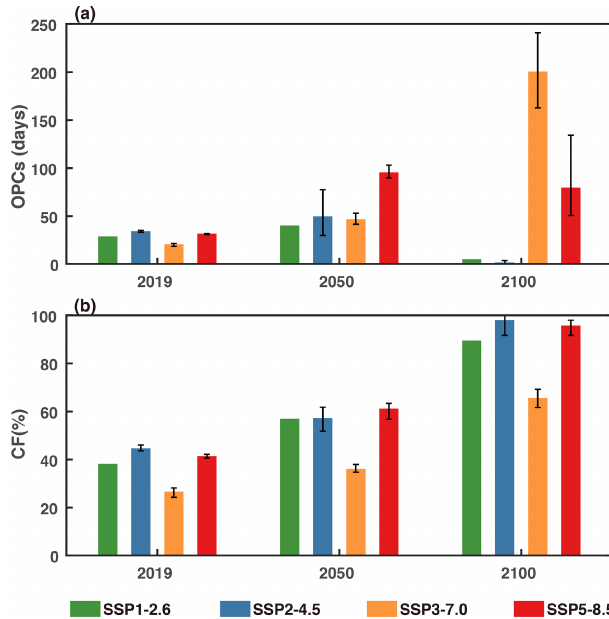
Figure 6. Averaged (a) OPCs and (b) CF values over NCP based on CMIP6 simulations under different SSPs for the periods of 2015– 2019, 2046–2050, and 2096–2100. The error bar shows the min- imum and maximum values simulated by the CMIP6 models for each SSP. Note that only one GCM is available for